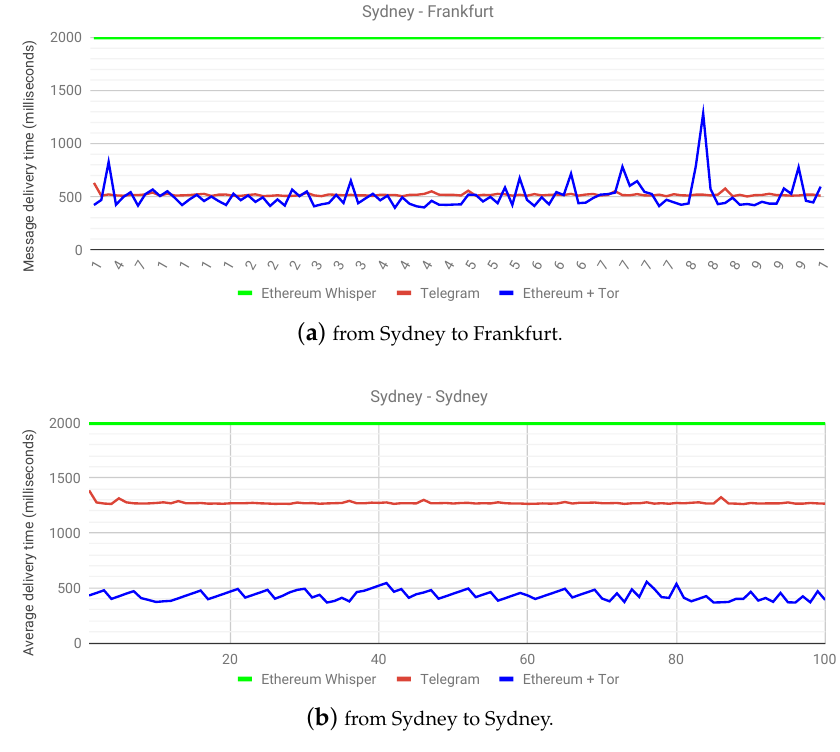
Figure 4. Message delivery times when delivering remote health monitoring data ( a ) from Sydney to Frankfurt and ( b ) from Sydney to